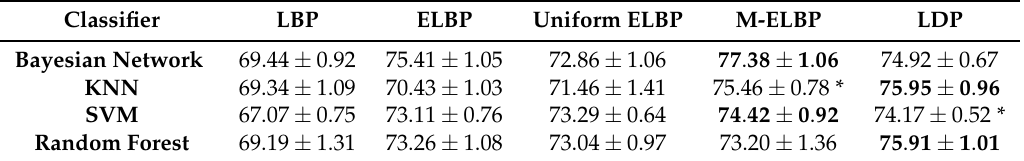
Table 7. Classification accuracy results by various classifiers for LBP variants for ROI size 256 × 256 pixels for 10-run 10-fold cross validation. (* indicates that the CA% are not significantly different from the best result using an unpaired t test ( p = 0.05) level).